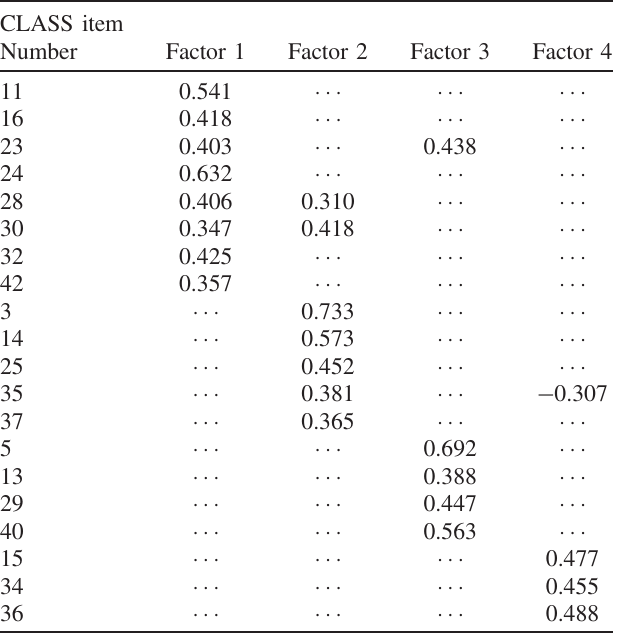
TABLE VI. Factor loadings from 20-item, four-factor EFA, sorted by factor. Loadings with magnitudes below 0.3 are omitted for clarity.